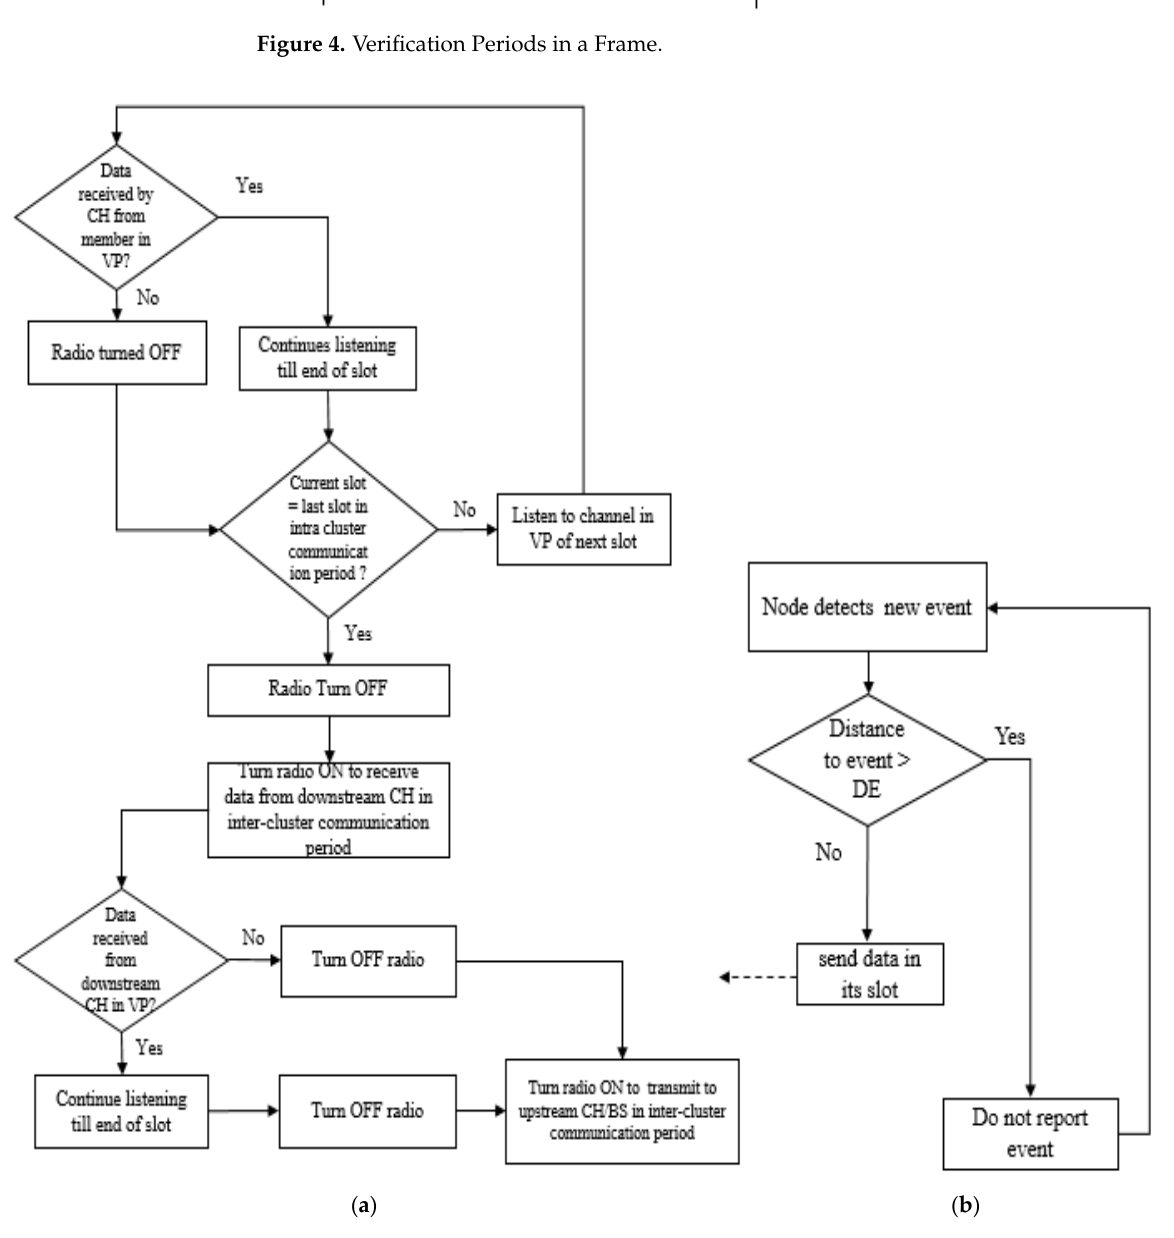
Figure 5. Steady-State Phase in Proposed Model: (a) Functioning of CH and (b) Functioning of member node.